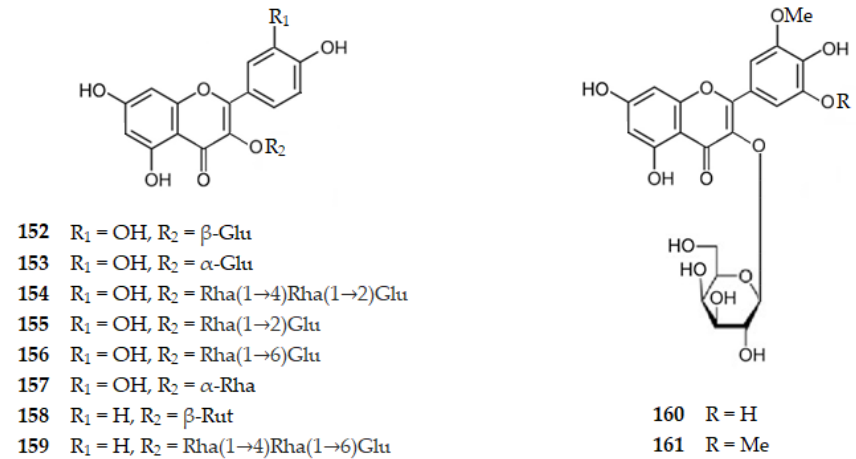
Figure 17. Structure of glycosylated flavonols 152 – 161 that inhibit AChE. Legend: Glu – glucopyranosyl, Rha – Rhamnopyranosyl and Rut – rutinosyl.